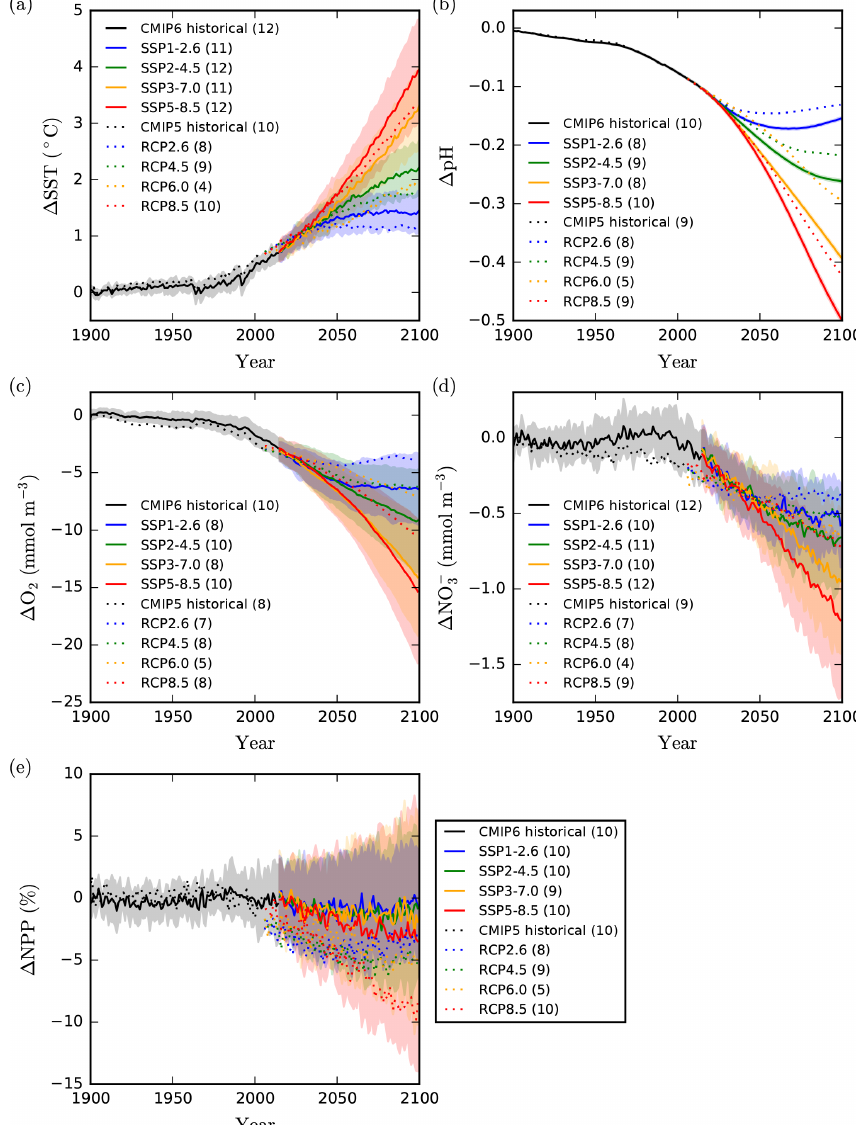
Figure 1. Global mean projections of upper-ocean impact drivers. Global mean projections of (a) sea surface temperature ( ◦ C), (b) surface ocean pH, (c) subsurface dissolved O 2 concentration (averaged between 100–600m ; mmolm − 3 ), (d) euphotic-zone NO − 0–100m ; mmolm − 3 ), and (e) depth-integrated net primary production (%). Values are anomalies relative to the 1870–1899 reference period. CMIP6 mean anomalies for the historical and SSP simulations are shown as solid lines with shading representing the inter-model SD. CMIP5 projections only show the multi-model mean. The model ensemble size for each scenario is given in